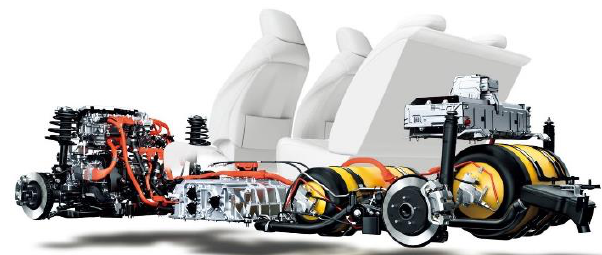
Fig. 14. Arrangement of the components of the fuel cell driveline (Toyota Mirai)